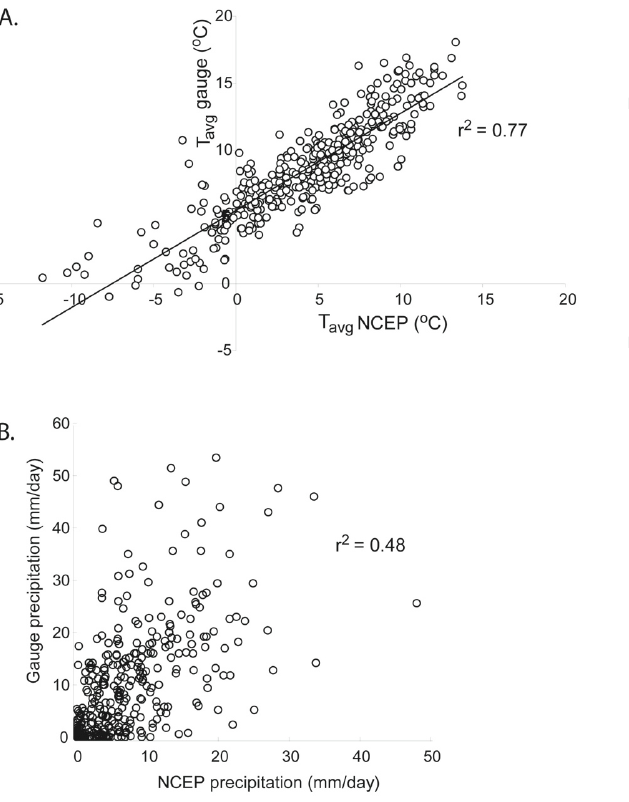
Fig. 5. Comparison of 398 daily-average measurements of tem- perature (a) and precipitation (b) made at Laguna San Rafael from March 2005 to April 2006, with NCEP-NCAR derived values at 2m above ground at gridpoint SR1. Correlation co-efficients are 0.77 and 0.48,